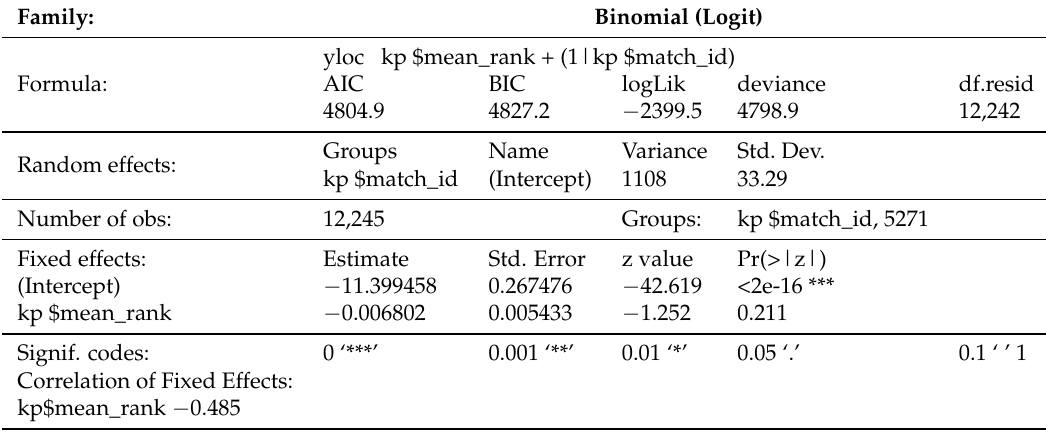
Table 4. Model 2: Generalized linear mixed model fit by maximum likelihood (Laplace Approximation) [’glmerMod’].